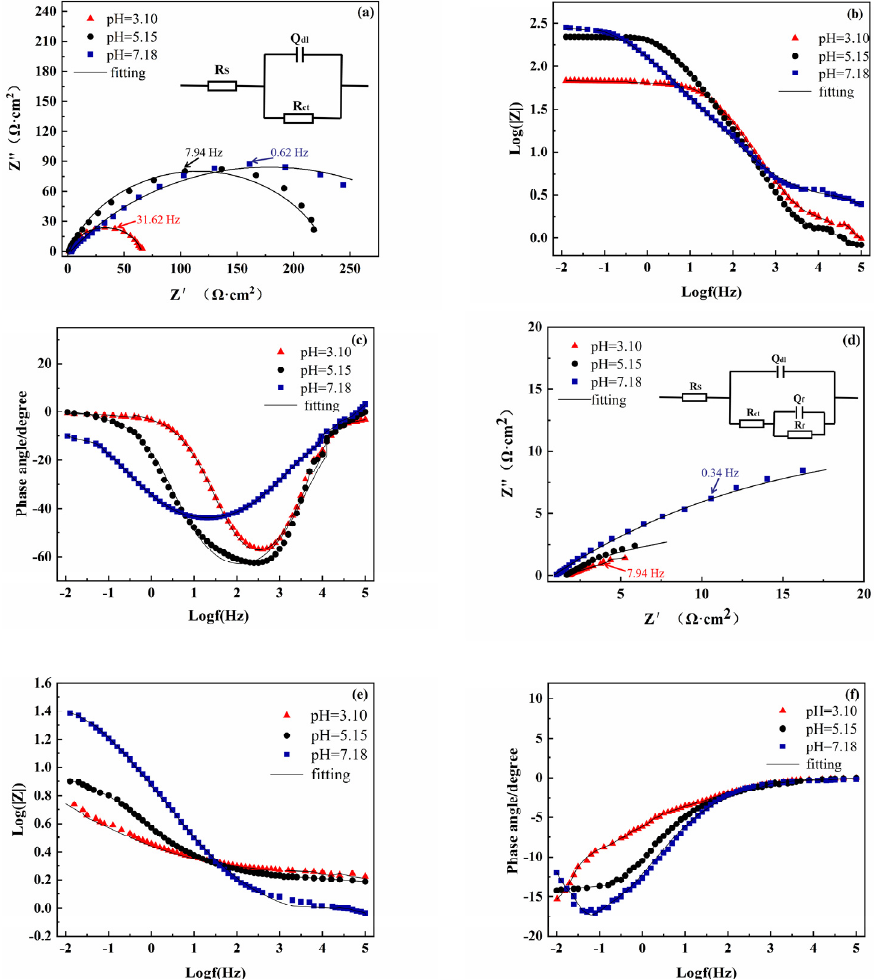
Figure 2. Nyquist plots and Bode plots of the bare electrode and S8-coated electrode at different pH values: ( a – c ) bare electrode, ( d – f ) S8-coated electrode. Table 2. EIS data fitted electrochemical parameters.